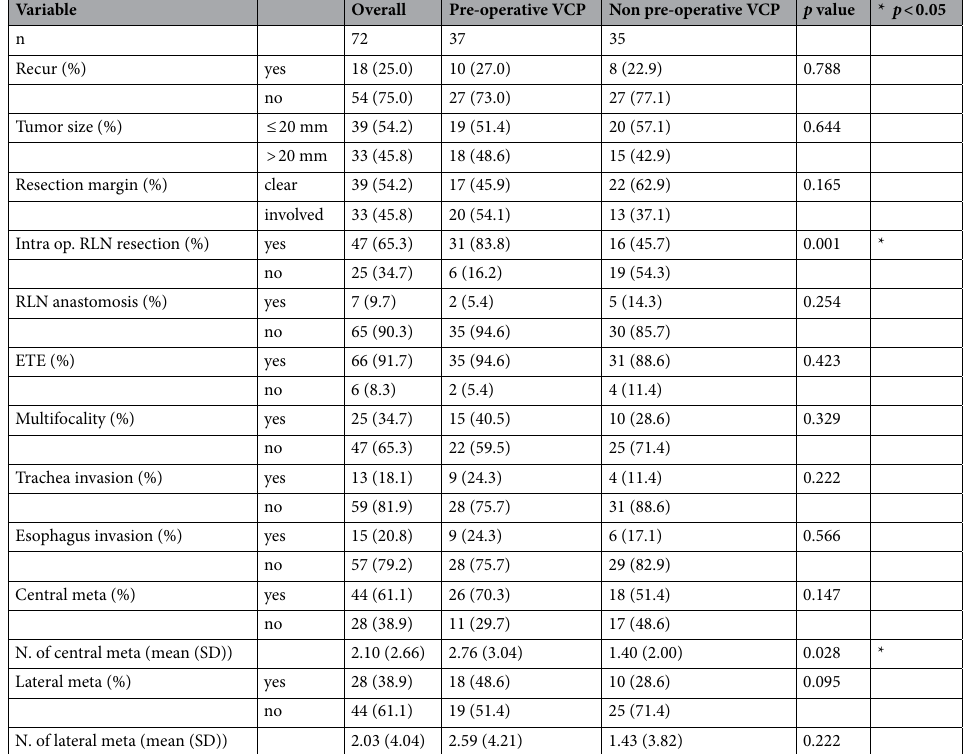
Table 3. Comparison of the pre-operative VCP group with non pre-operative VCP group. † VCP : Vocal cord palsy, RLN : Recurrent laryngeal nerve, ETE : Extrathyroidal extension, SD : Standard deviation.